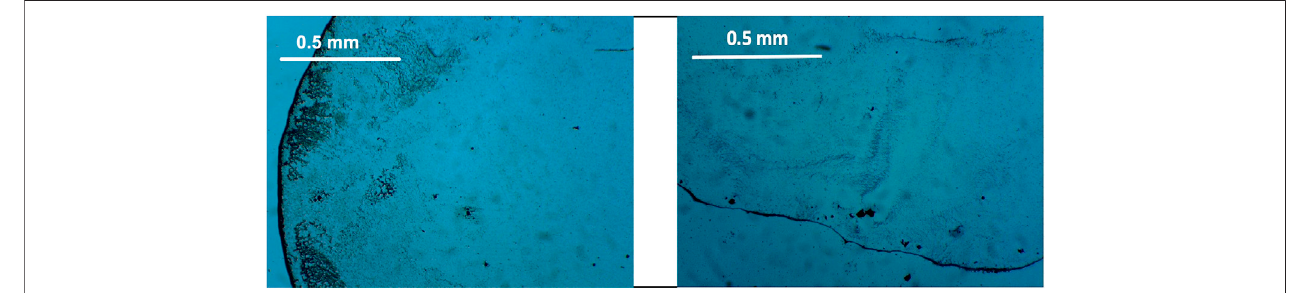
FIGURE 7 | Two examples of microscopic pictures of the accumulation of microspheres in dried droplets of unstirred water.